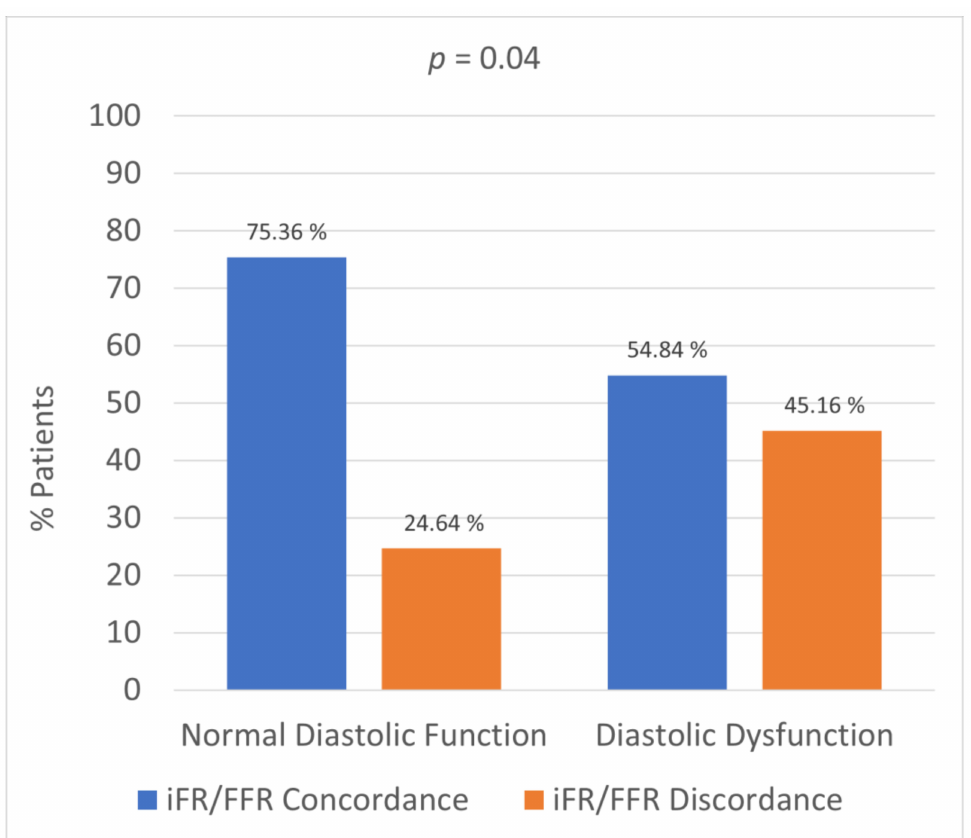
Figure 1. Comparison of iFR/FFR concordance and discordance between the two groups. iFR: instantaneous wave-free ratio; FFR: fractional flow reserve.